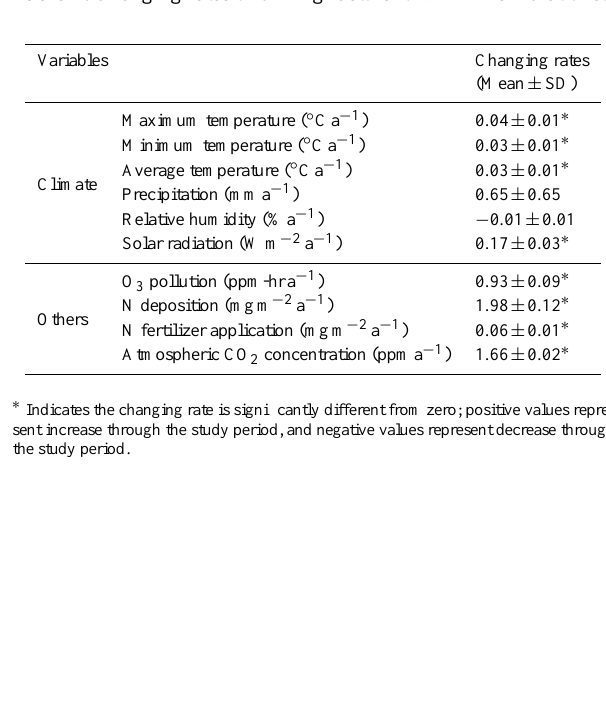
Table 2. Changing rates of driving factors for DLEM